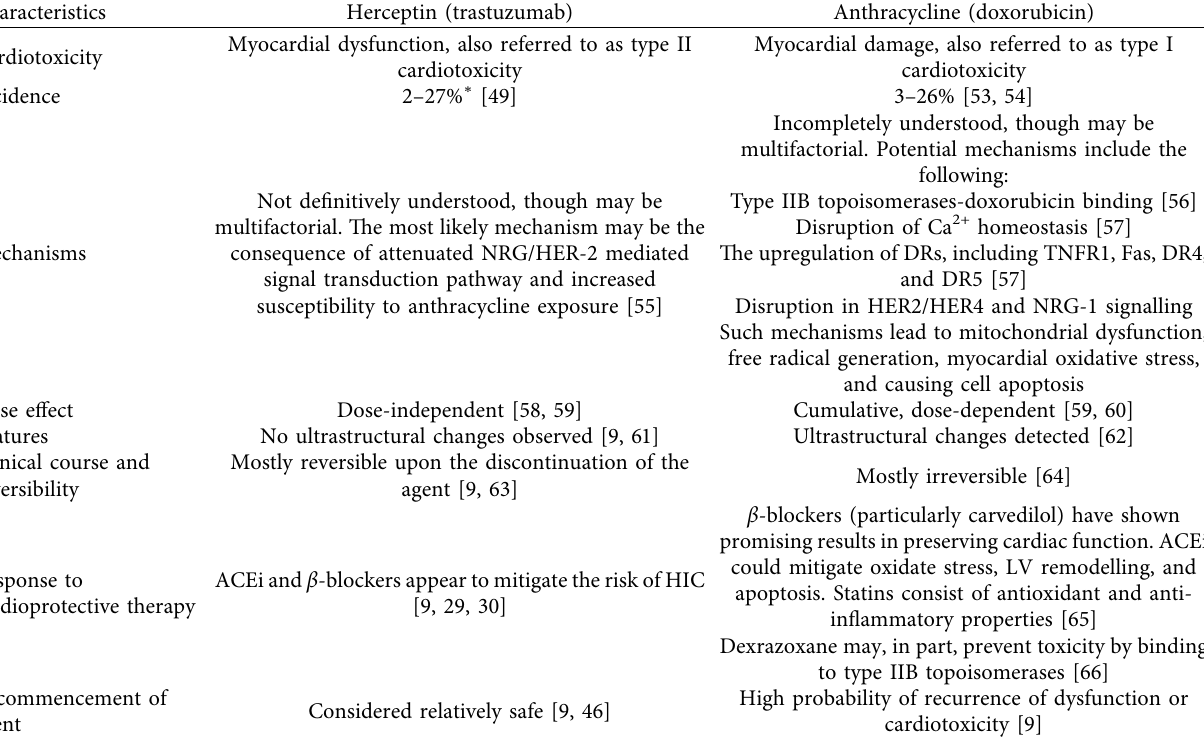
Table 3: Clinical features differentiating herceptin- and anthracycline-related cardiac